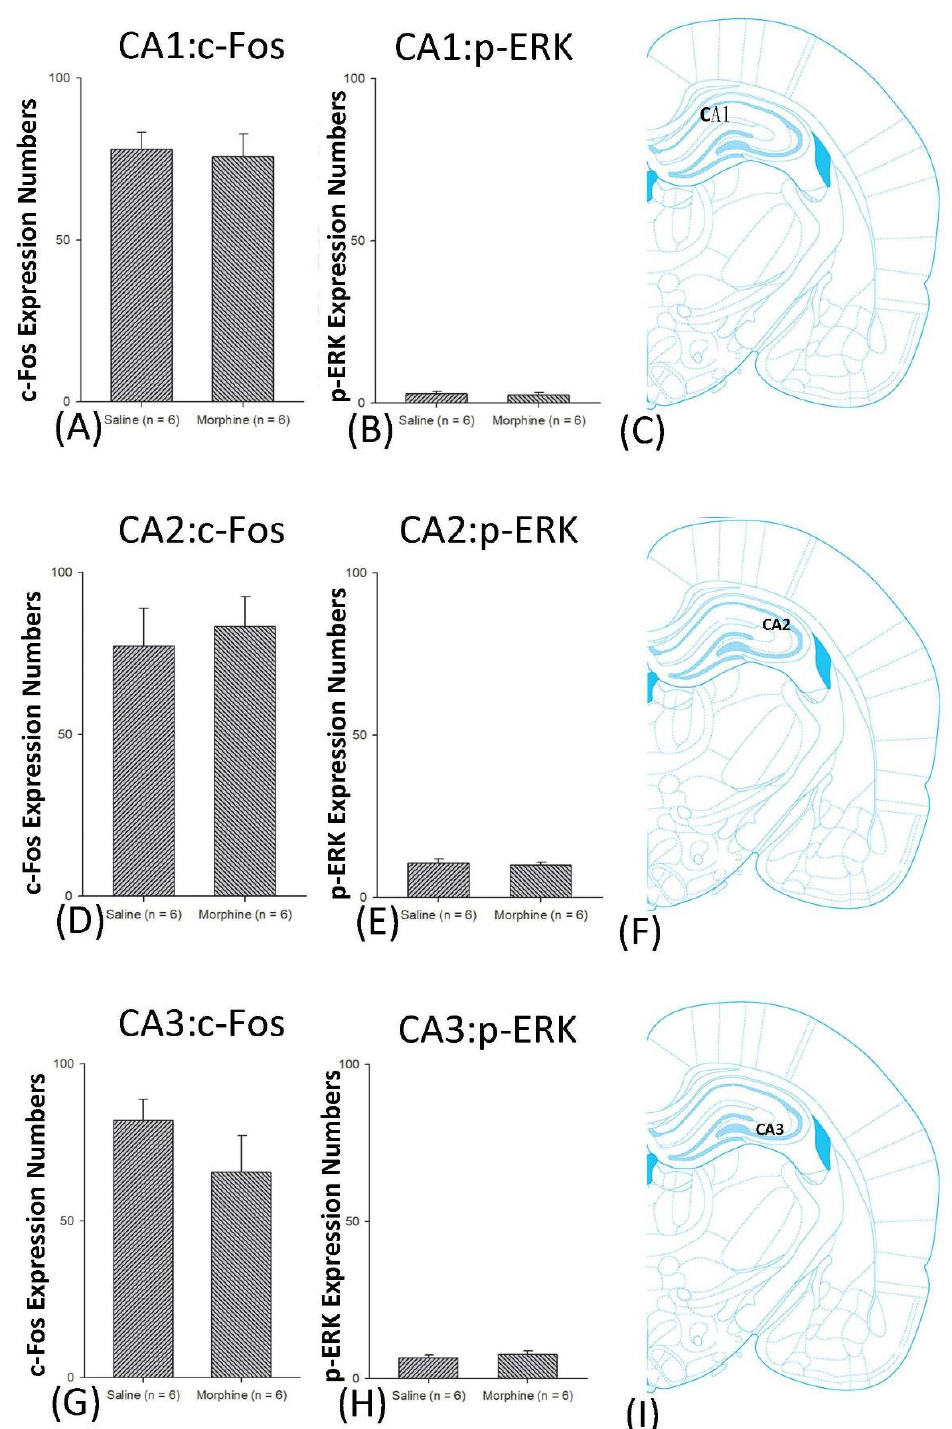
Figure 8. c-Fos or p-ERKimmunoreactivity in the CA1, CA2, and CA3 in conditioning. ( A ) c-Fos expression and ( B ) p-ERK expression in the CA1, ( D ) c-Fos and ( E ). p-ERK expression in the CA2, and ( G ) c-Fos and ( H ) p-ERK expression in the CA3 for conditioning. ( C , F , I ) show a schematic representation of the CA1, CA2, and CA3. * p < 0.05 when comparing the saline and morphine groups ( n = 6 per group).